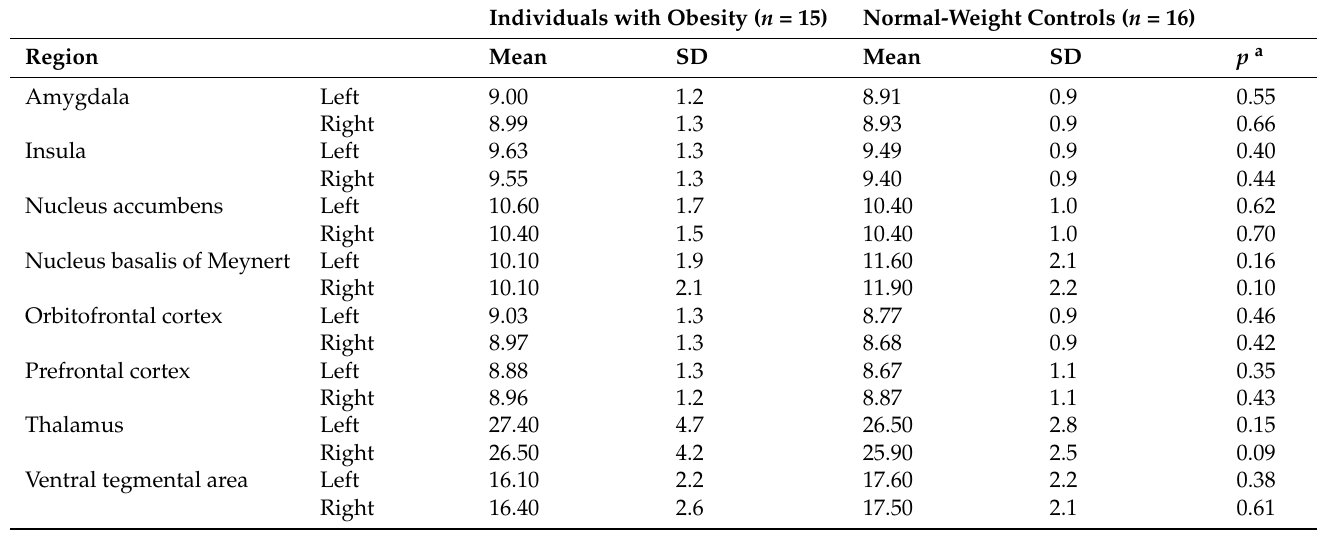
Table 2. Comparison of total distribution volumes (V T ) in regions of interest between individuals with obesity and normal ‐ weight controls .